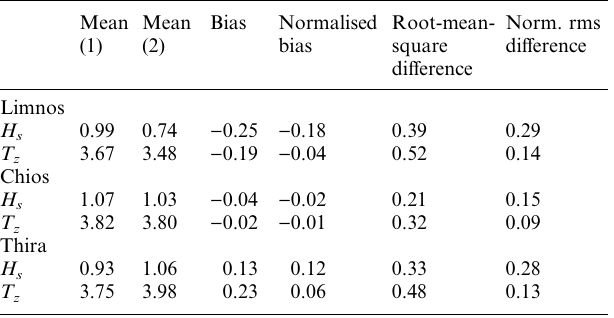
Table 6. Statistics for the storm December 1990, -48 points. Comparison of results from WAM model using UKMO and ECMWF winds